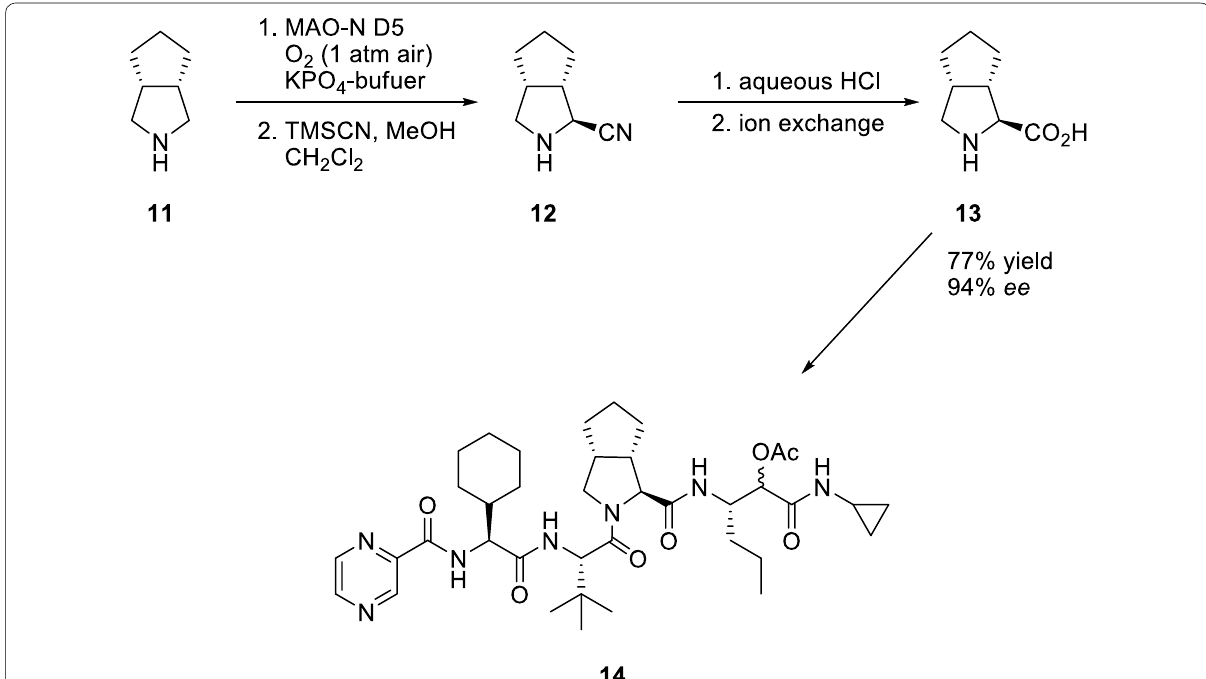
Fig. 4 Conversion of the symmetrical bicyclic pyrrolidine 11 to an l -proline analog 13 via initial MAO-N catalyzed desymmetrization followed by diastereoselective addition of cyanide and subsequent